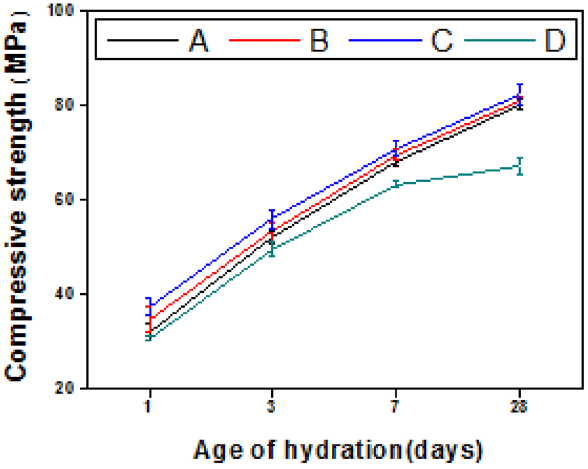
Figure 6. Compressive strength versus age of hydration for hardened blended cement pastes (mixes